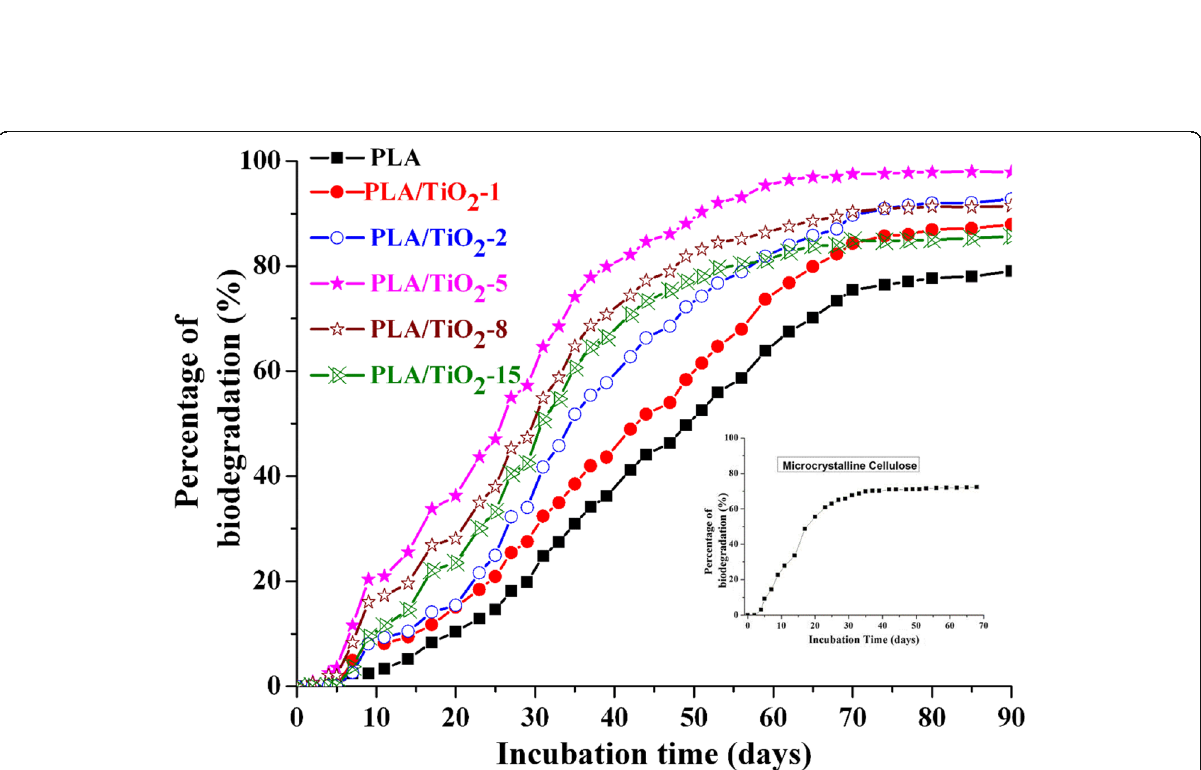
Fig. 5 Percentage of biodegradation as a function of incubation time for pure PLA and PLA/TiO 2 nanocomposites. The insert is the percentage of biodegradation as a function of time for microcrystalline